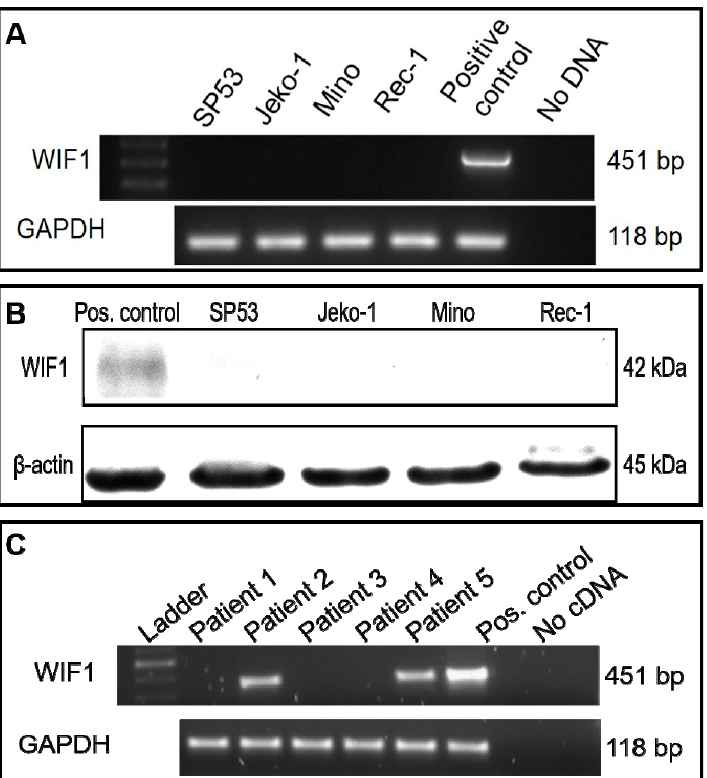
Figure 1. Wnt inhibitory factor-1 (WIF1) mRNA and protein expression were not detected in mantle cell lymphoma (MCL) cell lines and the majority of patient samples. ( A ). WIF1 mRNA expression was not detected in the 4 tested MCL cell lines. ( B ). WIF1 protein expression was not detected in the 4 tested MCL cell lines. ( C ). WIF1 is not expressed in three out of five MCL patient samples. RNA and protein derived from transfected JeKo-1 cells with WIF1 were used as a WIF1 positive control in all experiments.